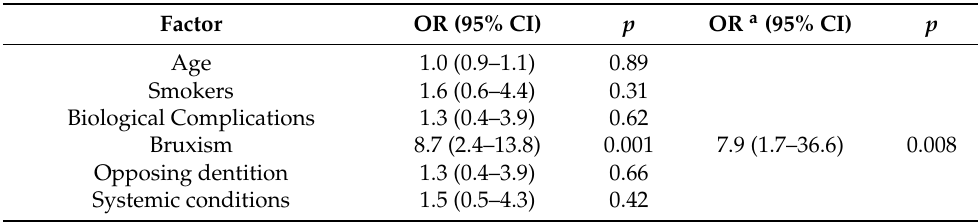
Table 5. Risk indicators for Mechanical Complications (OR stands for Odds Ratio, while CI stands for Confidence Interval, p < 0.05 was considered statistically significant, we replicate the test for significant results